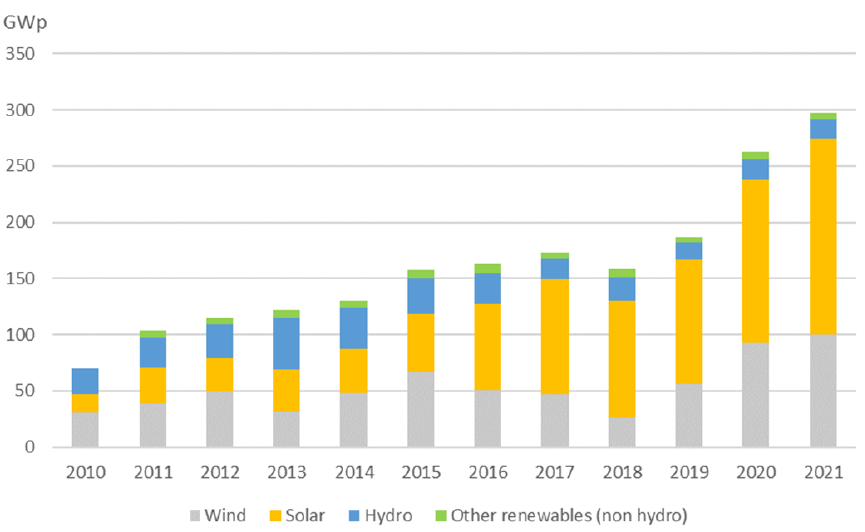
Figure 1. Evaluation of renewable energy annual